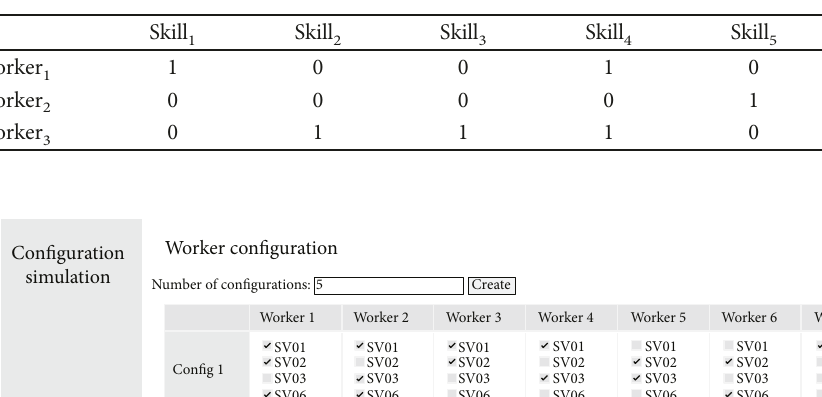
Table 1: The layout of the fl ow-shop system.